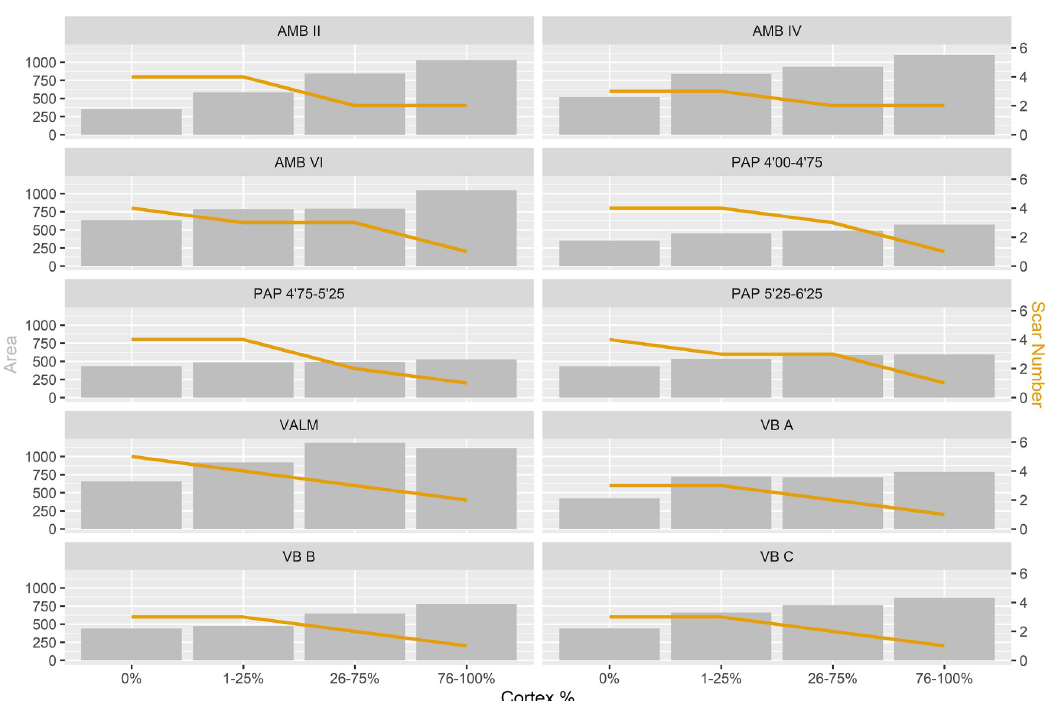
Fig 4. Comparison of the interaction between scar number and area of blanks by cortex frequency for each assemblage in this study.